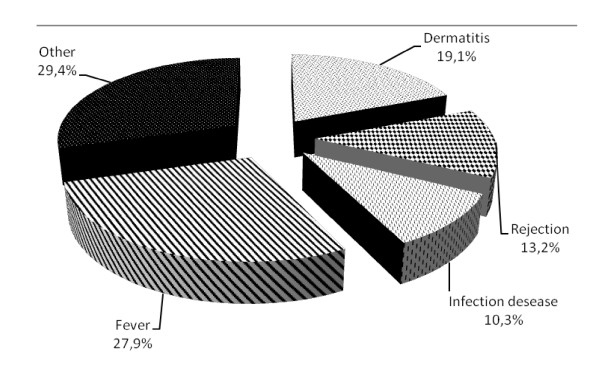
Type of complications following the practices of piercing and tattoos.